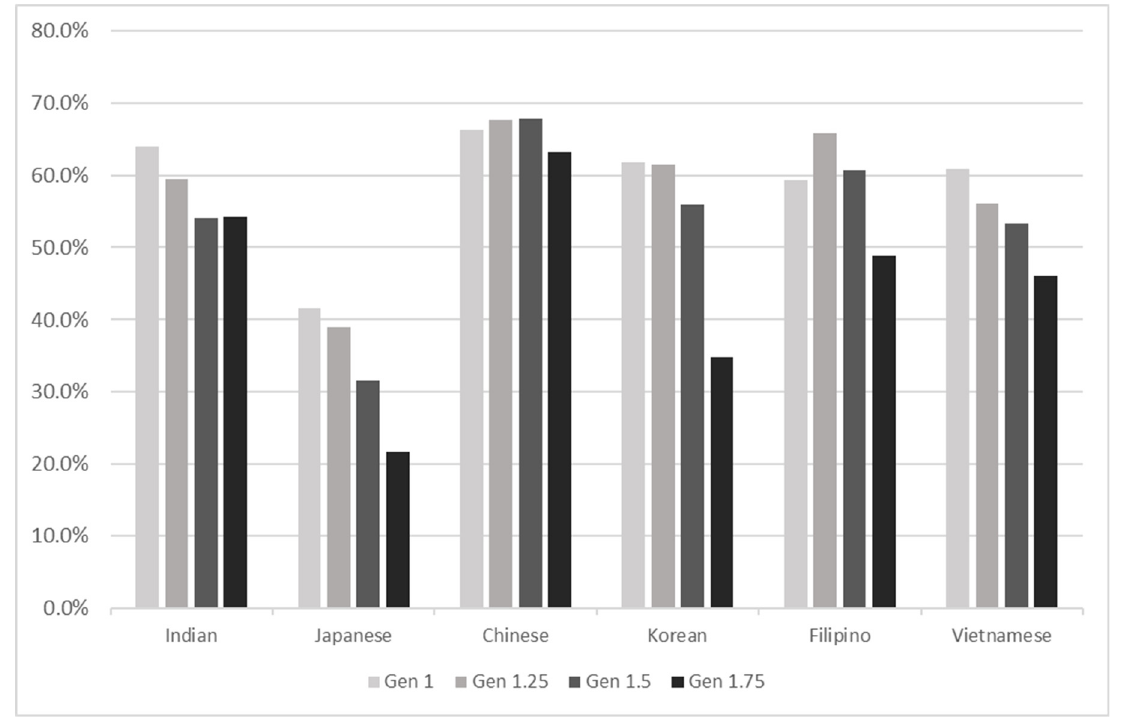
Figure 1. Percent Living in Ethnic Areas by Group and Generation.